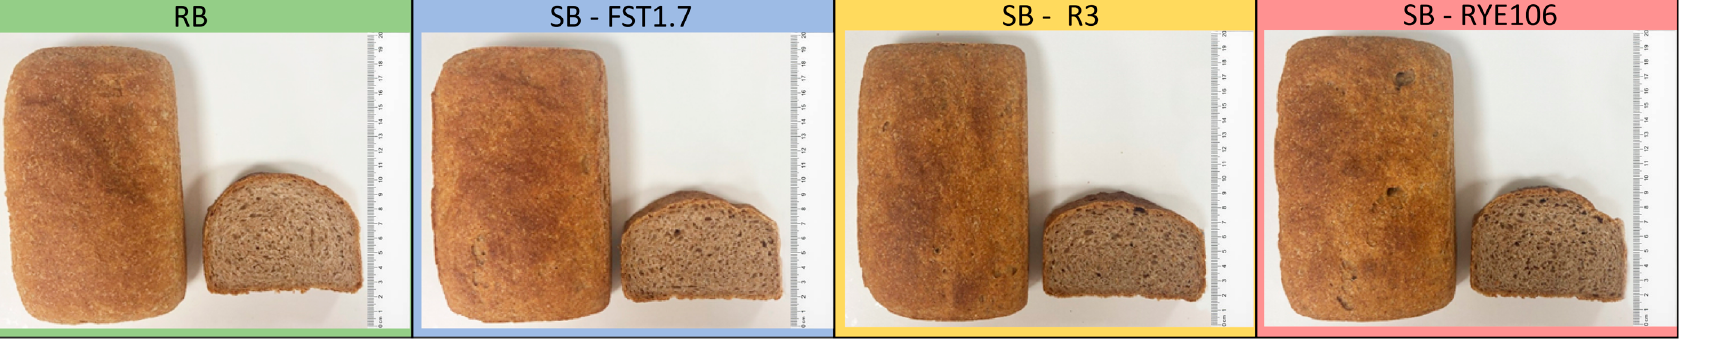
Figure 6. Representative images of the whole-wheat breads: RB, produced with commercial baker’s yeast preparation (2%; Puratos, Belgium) and with baker’s yeast and sourdough (20%) based on homofermentative fermentation by Lactiplantibacillus plantarum FST1.7 (SB—FST1.7), Lacticaseibacillus paracasei R3 (SB—R3), and Pediococcus pentosaceus RYE106 (SB—RYE106).